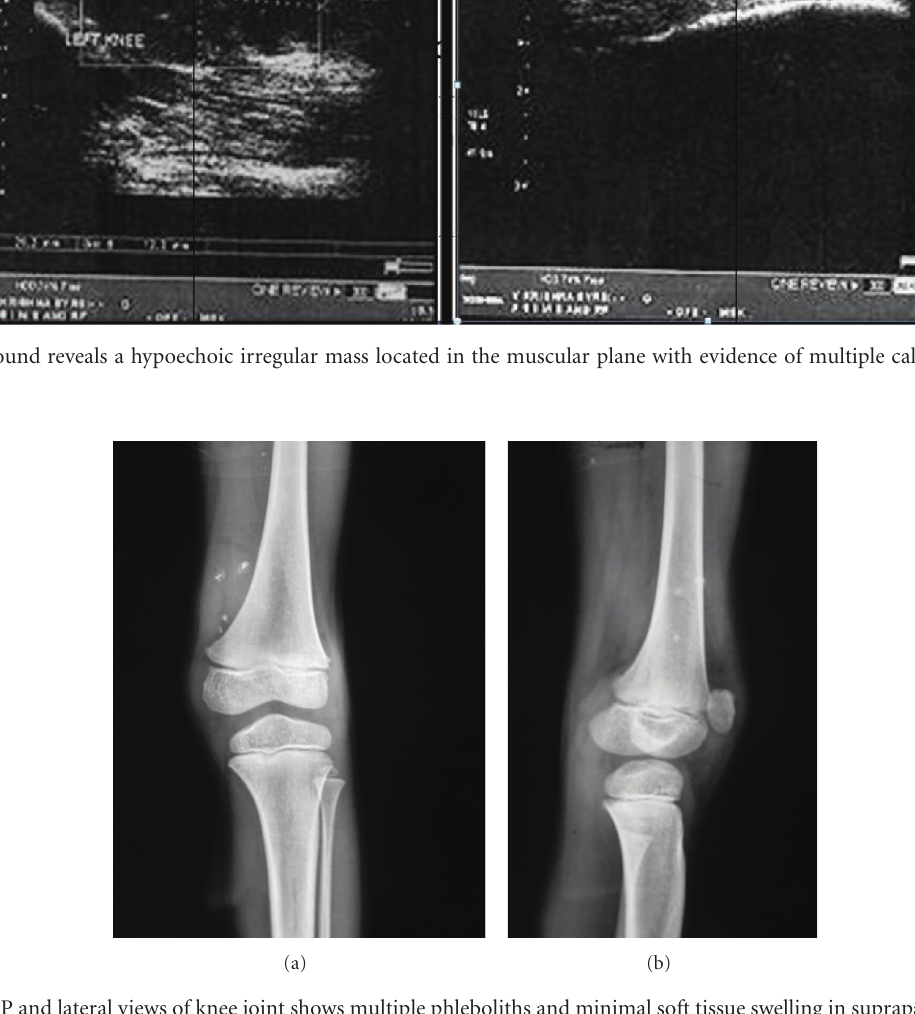
of the patellar tendon were normal and the patellar tap was negative. There was no distal neurovascular deficit or bruit. Limb length was equal to the contralateral limb. Knee movements were of full